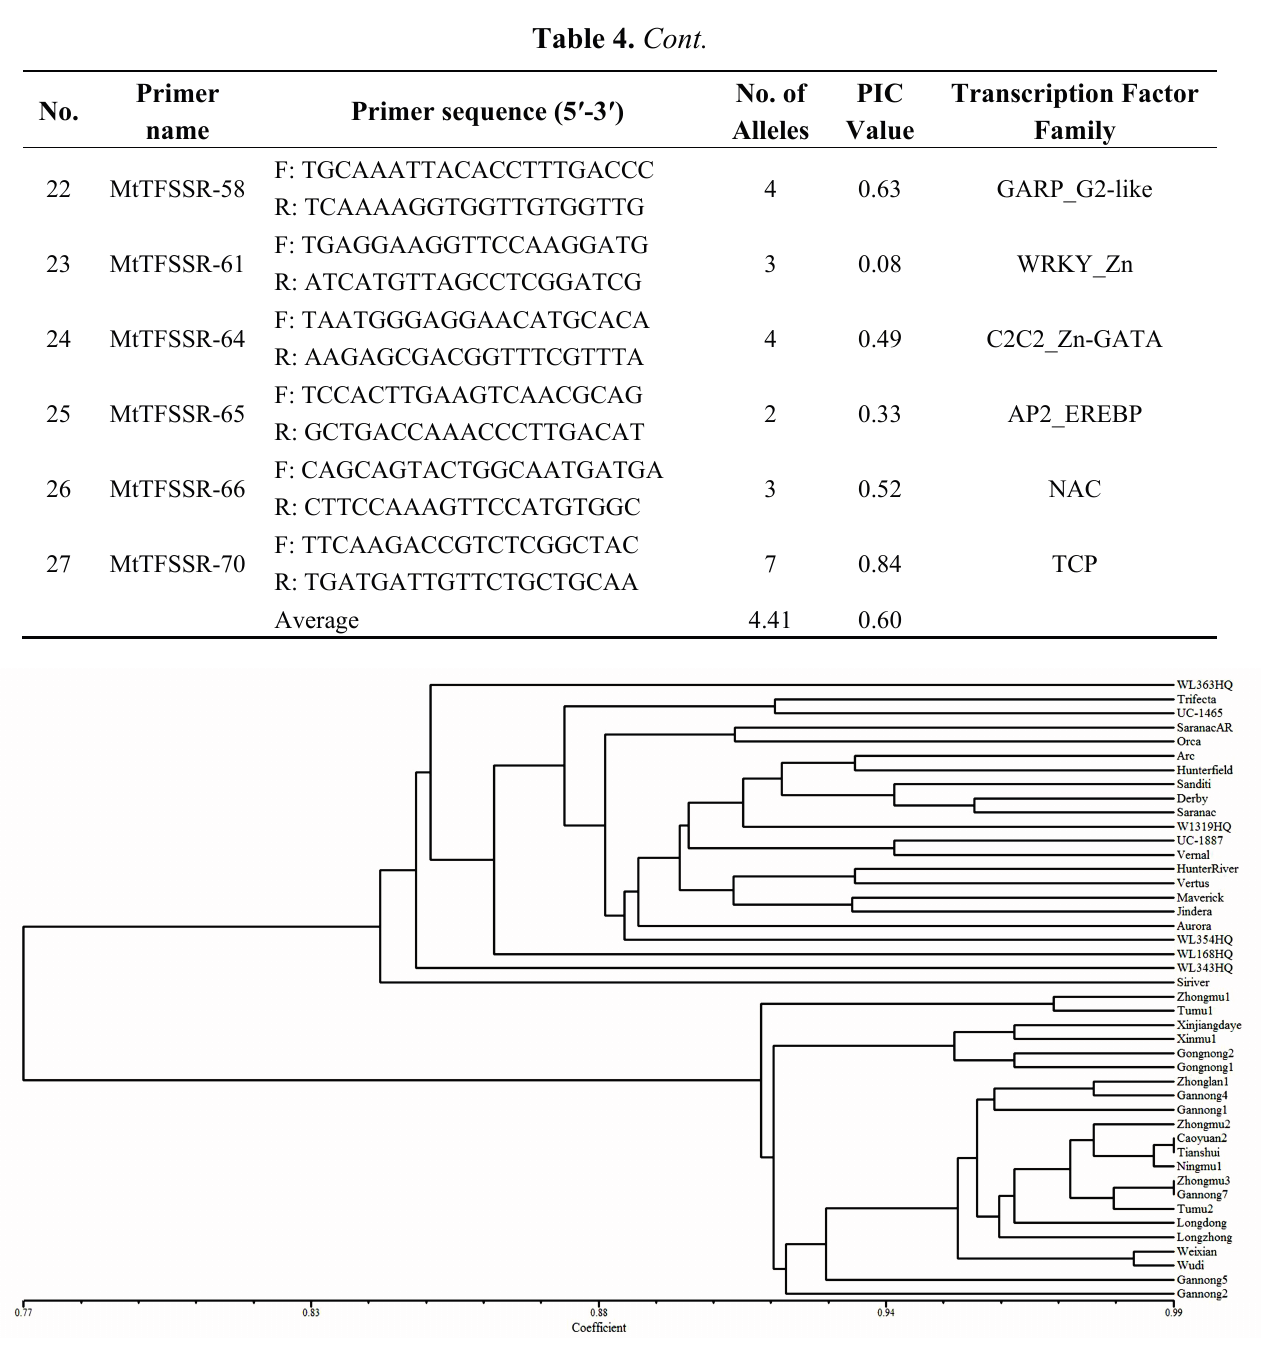
Figure 2. The dendrogram of 44 alfalfa accessions based on UPGMA analysis using 27 polymorphic TFGM